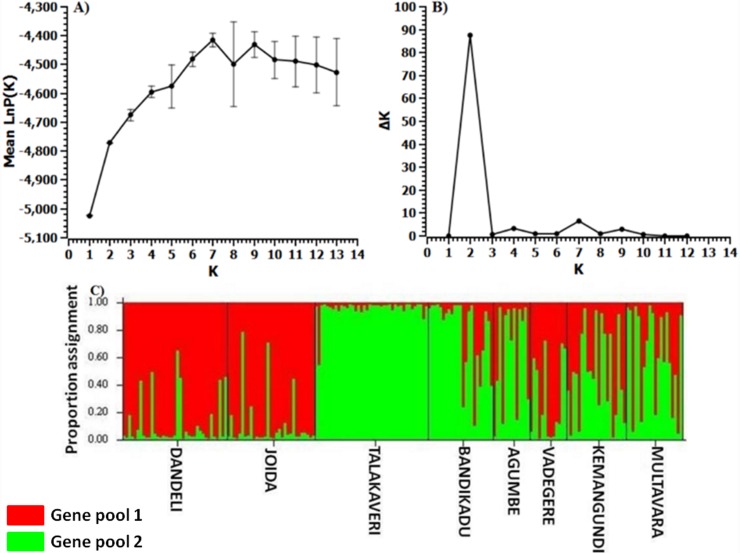
Results of Bayesian model based clustering method (STRUCTURE) analysis.a) Posterior probability of the data LnP(D) (±SD) against the number of K clusters, and increase of LnP(D) given K, calculated as (LnP(D)k–LnP(D)k–1) b) Delta K values from the mean log-likelihood probabilities from STRUCTURE runs where inferred clusters (K) ranged from 1 to 14 (c) Estimates of the proportion of ancestry, Q, in each of K = 2 clusters for 198 Nothapodytes nimmoniana individuals using the model-based cluster analysis, STRUCTURE (version 2.1). Note: A single vertical line represents each individual with estimated membership in each cluster denoted by the different colors. The analysis was based on seven SSR loci and used admixture model of ancestry. Individuals are separated based on their population and black vertical lines in the bar chart are population identifiers. Populations are ordered as per their population name.